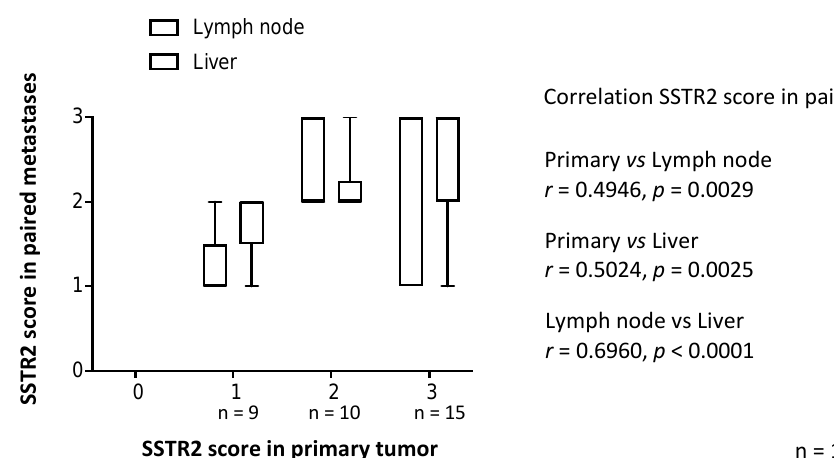
Figure 4. SSTR2 score in primary tumor compared with corresponding metastases. Samples from both primary tumor, lymph node and liver metastases from 34 patients were analyzed (3 samples each from 34 patients, in total 102 samples). When samples from metastases were sorted according to the SSTR2 score in the corresponding primary tumor, a consistency in SSTR2 score between primary tumors and metastases was observed. The figure illustrates a “box and whiskers” plot: boxes show 25th to 75th percentile and whiskers indicate range. Spearman rank correlation.